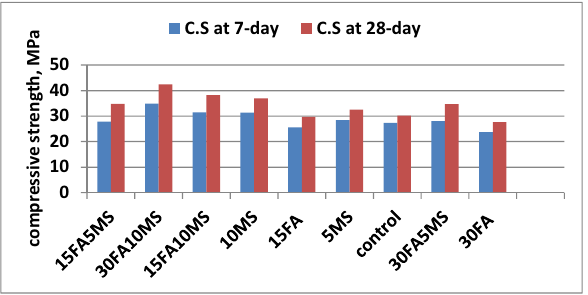
Figure 2: Compressive strength of all concrete mixtures.